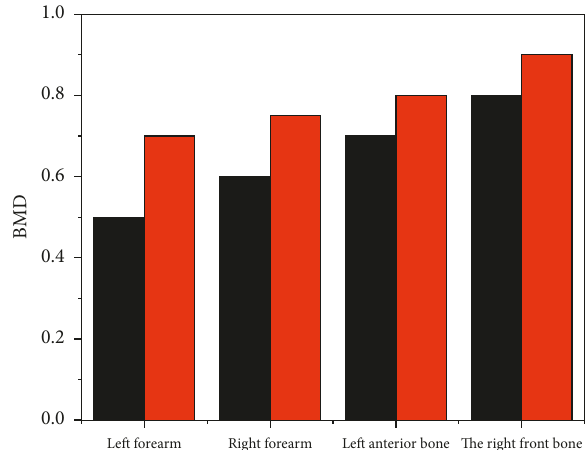
Figure 2: BMD comparison results of male athletes before and after the